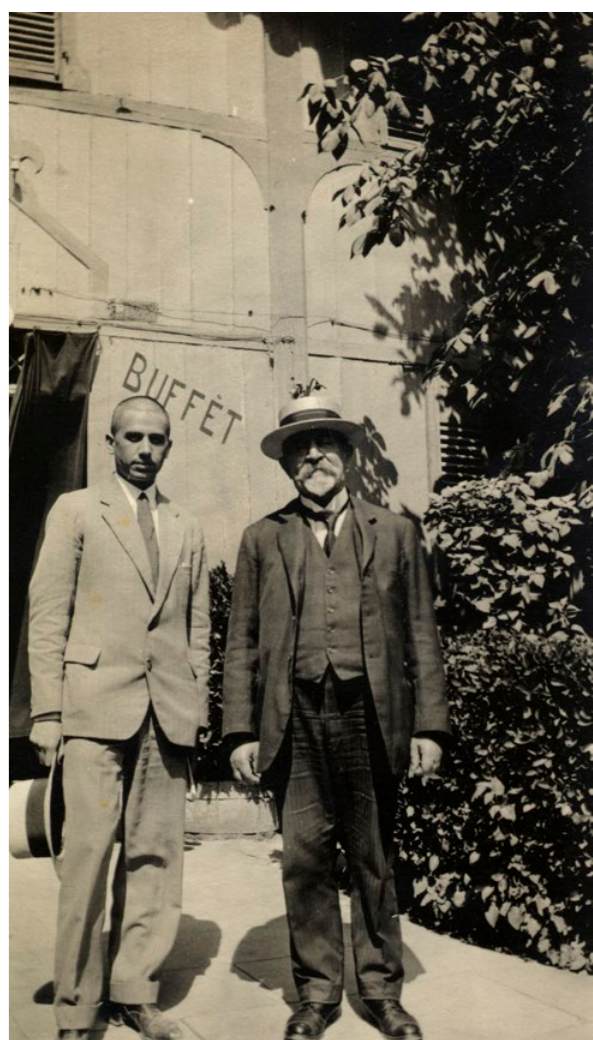
Figure 2. Zvi with the “Maestro” Angelo Angeli in Pracchia (Pis- toia, Italy); (from the private collection of the Jolles-Bainbridge family, now in the Fondo Jolles at Florence University Museum of Natural History